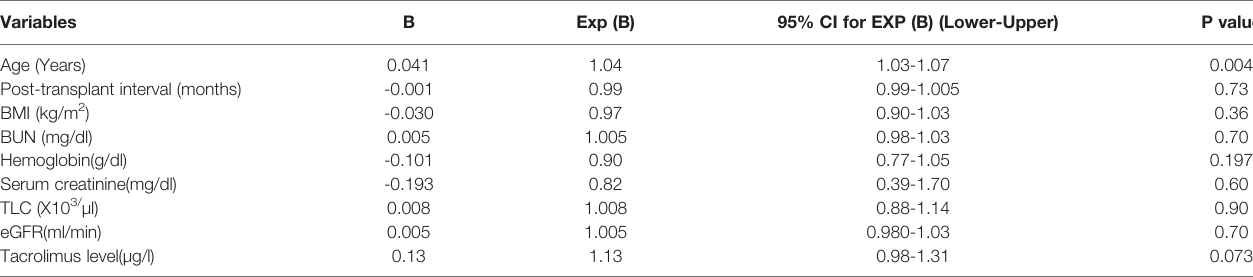
TABLE 5 | Multivariate analysis predicting seroconversion in RTRs.